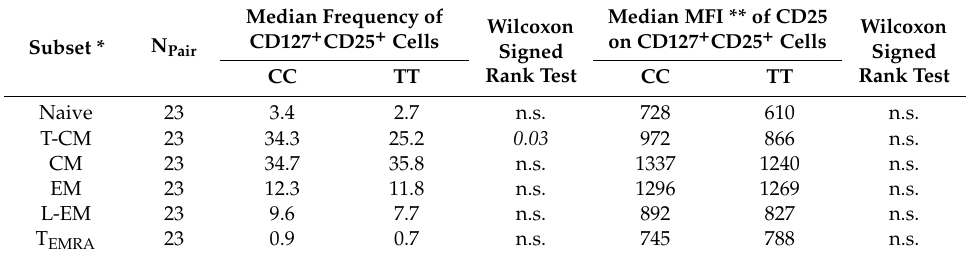
(Table 2: p = 0.03). We observed no associations of the MS ‐ associated IL2RA genotype with frequency or surface expression (MFI) of CD25 on the other CD127 + CD25 + CD8 + T cell subsets (Table 2). In CD8 + T cells, the CD127 lo CD25 hi population only represented 0.49% (IQR: 0.24–1.2%) and therefore excluded from statistical analysis. Table 2. IL2RA genotype effects on the CD127 + CD25 + population in relation to CD8 + T cell differentiation. A risk genotype (TT) is defined as a homozygous carrier of the risk allele (T) for both MS ‐ associated IL2RA SNPs rs2104286 and rs11256593. A protective genotype (CC) is defined as a homozygous carrier of the protective allele (C) for both MS ‐ associated IL2RA SNPs rs2104286 and rs11256593.